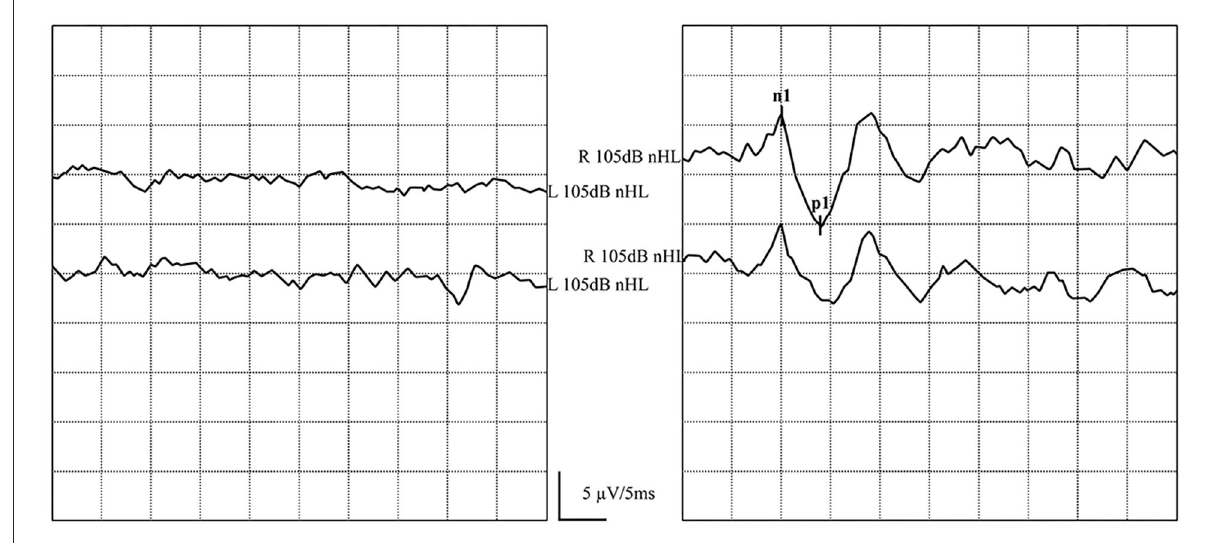
FIGURE6 Normal and abnormal ACS-oVEMP waveforms: Not elicited on the left side and elicited on the right side. (left) Abnormal ACS-oVEMP waveforms: Not elicited on the left side. (right) Normal ACS-oVEMP waveforms: Elicited on the right side.